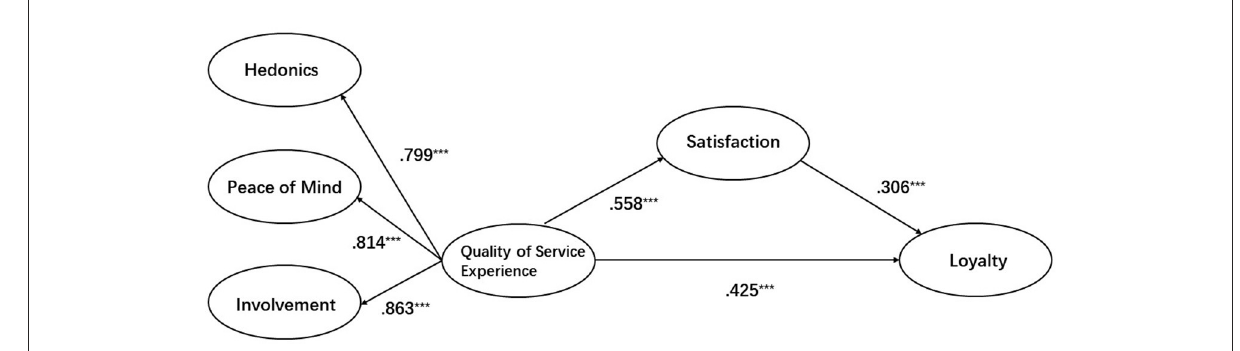
FIGURE2 The results of path